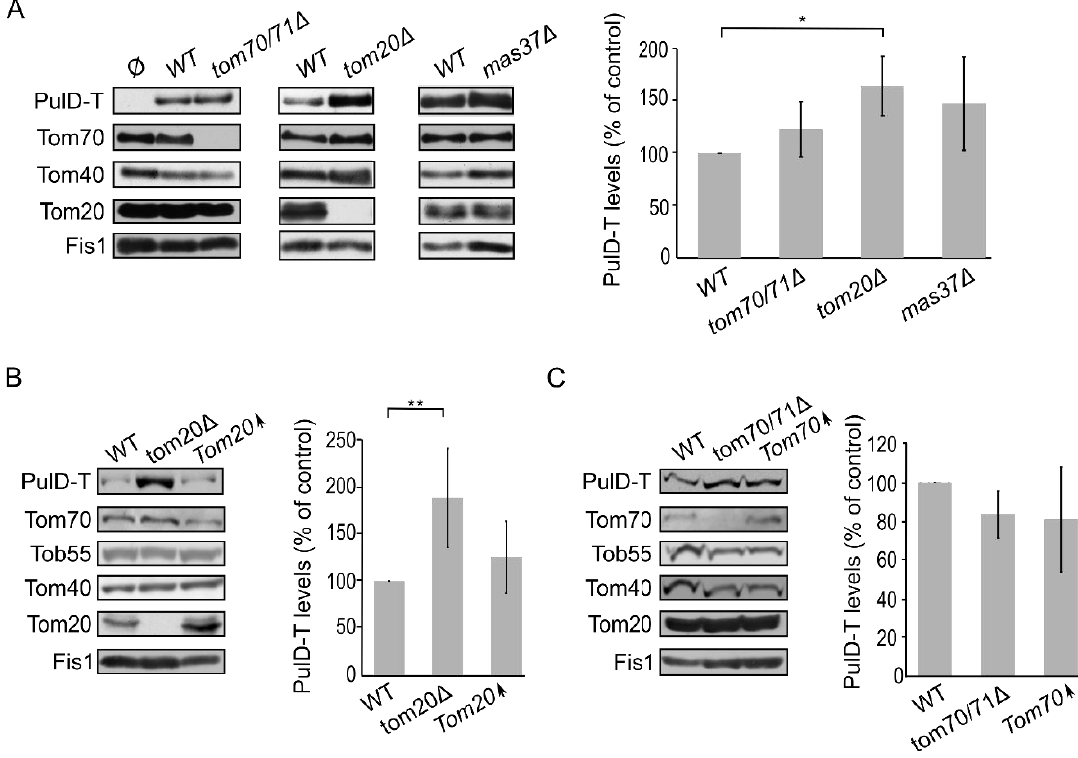
FIGURE 5: The assembly of PulD-T in mitochondria is enhanced in the absence of Tom20 . (A) Mitochondria were isolated from the indicated strains transformed with either an empty vector (Ø) or a plasmid encoding PulD-T. Further treatment and analysis were as described in the legend of Fig. 4A. (B) Crude mitochondria were obtained from wild type (WT), tom20 Δ or a strain overexpressing TOM20 (Tom20↑) harbour‐ ing a plasmid encoding PulD-T. Further treatment and analysis were as described in the legend of Fig. 4B. (C) Crude mitochondria were ob- tained from WT, tom70/71 Δ or a strain overexpressing TOM70 (Tom70↑) h arbouring a plasmid encoding PulD-T. Further treatment and analy- sis were as described in the legend of Fig.